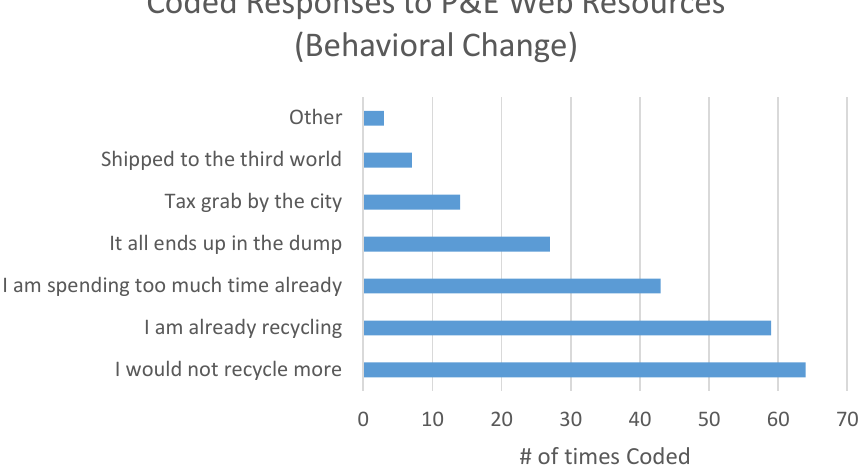
Figure 18. Coded Responses to P&E Web Resources (Behavioral Figure 17. Coded Responses to P&E Web Resources (Behavioral Change).